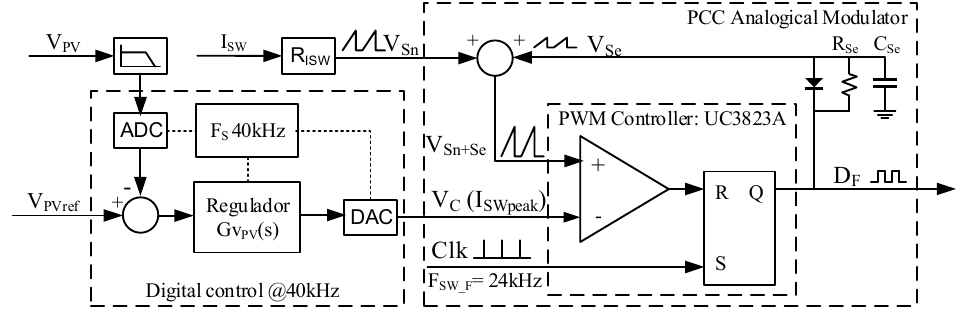
Figure 5. Flyback DC-DC PCC control scheme.